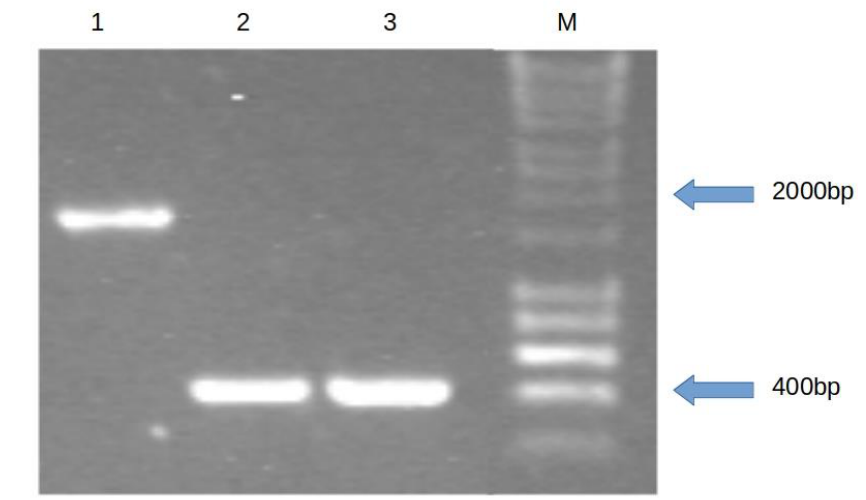
Figure 2. PCR confirmation of the transposon insertion in lmo1930. Bands are the result of amplification with lmo1930F and lmo1930R as described in Materials and Methods. Lanes: 1, mutant H1H3; 2, parental strain 2010L-1723, 3, genetically-unrelated, serotype 1 / 2b strain 2011L-2858; M, molecular weight markers (HyperLadder 1kb; Bioline, Boston, MA, USA).